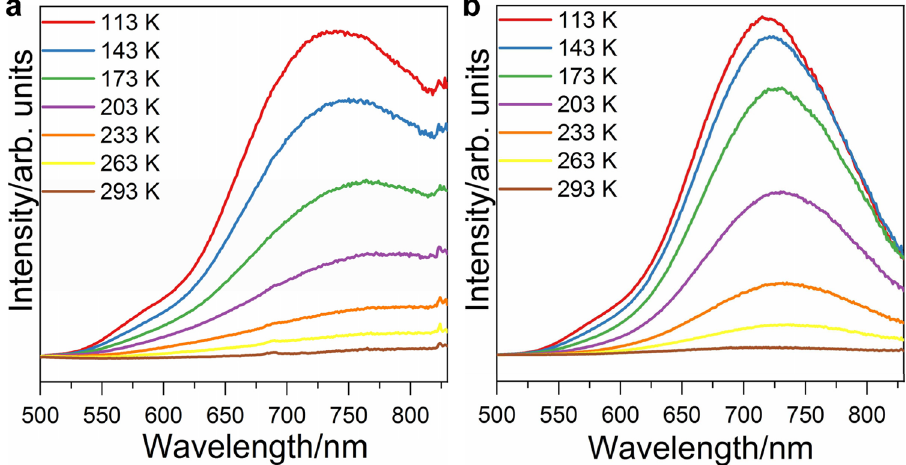
Fig. 7 Luminescence spectra of SD/Ag51b and SD/Ag72a. Variable-temperature emission spectra for SD/Ag51b ( a ) and SD/Ag72a ( b